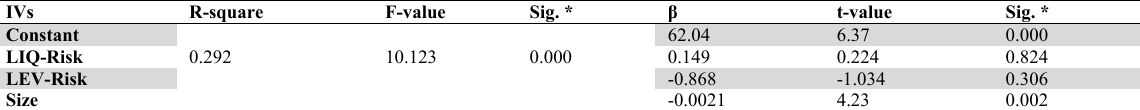
Effects of liquidity risk and leverage risk on ROA IVs R-square